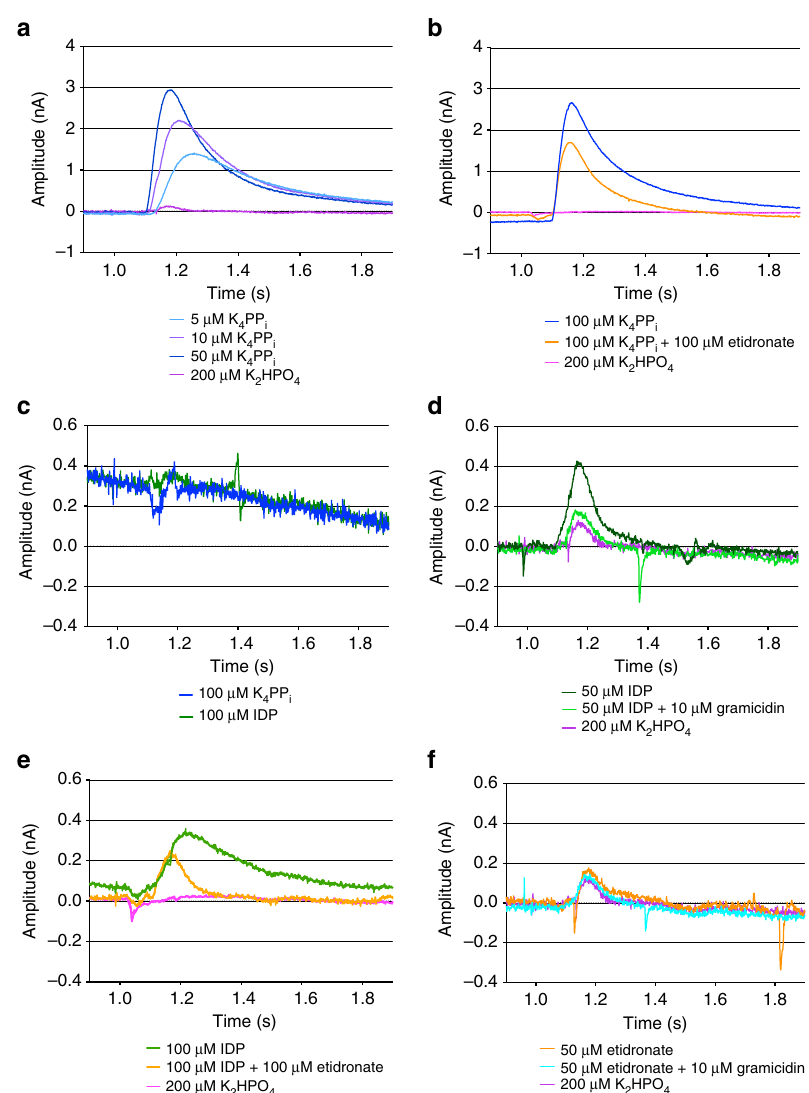
Figure 4 | Electrometric sensor traces for H þ -pumping. Traces obtained for VrPPase from the Nanion SURFE 2 R N1 machine. ( a ) Effect of increasing concentrations of K 4 PP i and K 2 HPO 4 on signal amplitude of VrPPase proteoliposomes. ( b ) Effect of etidronate addition to K 4 PP i -induced signals of VrPPase proteoliposomes. ( c ) Effect of K 4 PP i and IDP on liposomes without pyrophosphatase. ( d ) Effect of IDP on amplitude in the presence and absence of gramicidin compared with K 2 HPO 4 . ( e ) Effect of etidronate addition to IDP-induced signals of VrPPase proteoliposomes. ( f ) Effect of etidronate on amplitude in the presence and absence of gramicidin compared with K 2 HPO 4 . Activating buffer containing substrate or inhibitor was added at 1s and removed at 2s. Two anomalous peaks (covering o 0.01s) were removed from e for the sake of